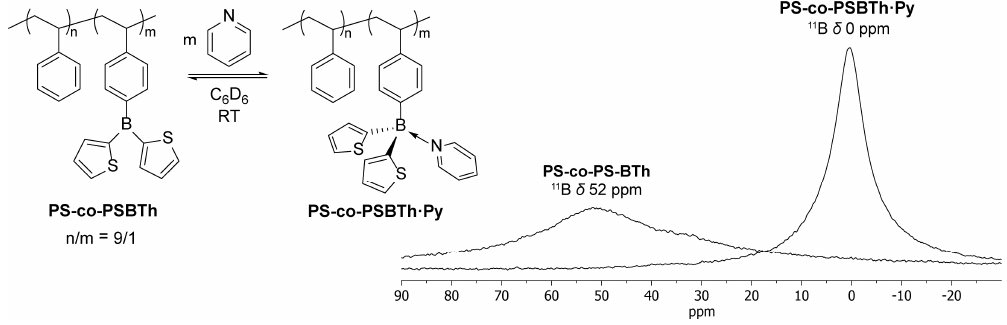
Figure 3. Stoichiometric reaction between PS-co-PS-BTh and pyridine, and the resulting 11 B NMR spectra.